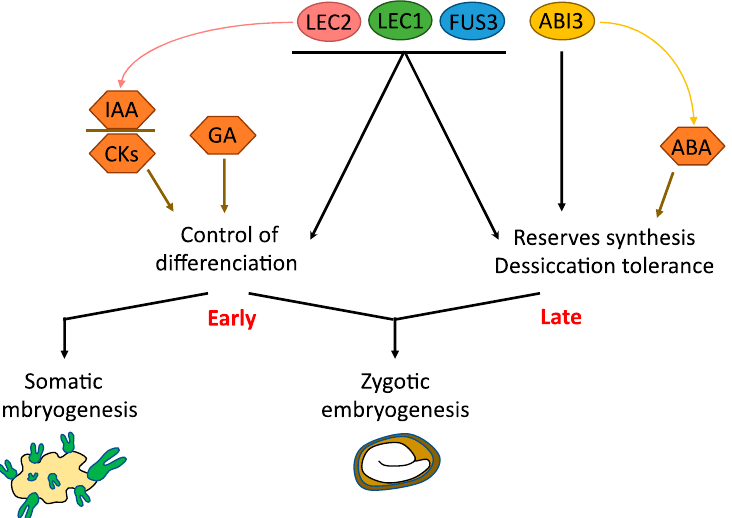
Figure 1. The roles of LAFL genes in somatic embryogenesis (SE) and zygotic embryogenesis (ZE). IAA: auxins, CKs: cytokinins, GA: gibberellins.